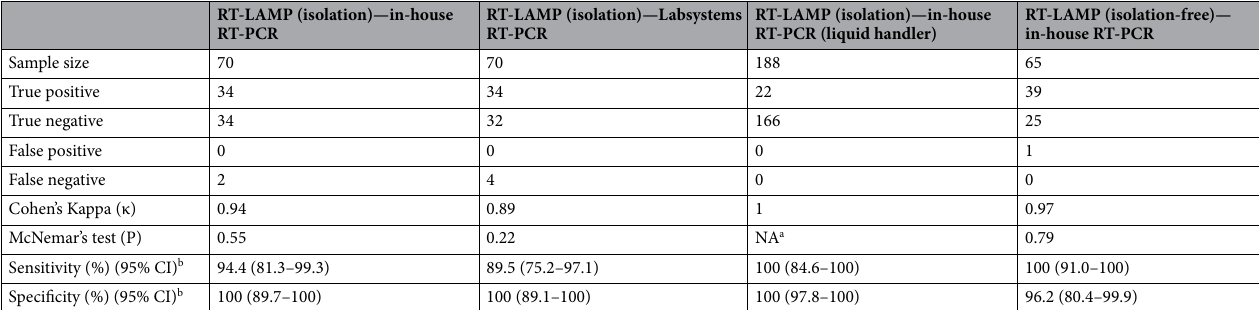
Table 1. Method comparison of the SARS-CoV-2 RT-LAMP with RNA isolation with (I) the in-house RT-PCR protocol, (II) the commercial Labsystems RT-PCR kit and (III) the in-house RT-PCR using a liquid handler. Further, the method comparison between the isolation-free protocol of the RT-LAMP and the in-house RT-PCR is shown. a Not available. McNemar’s test cannot be calculated for perfect agreement. b Confidence